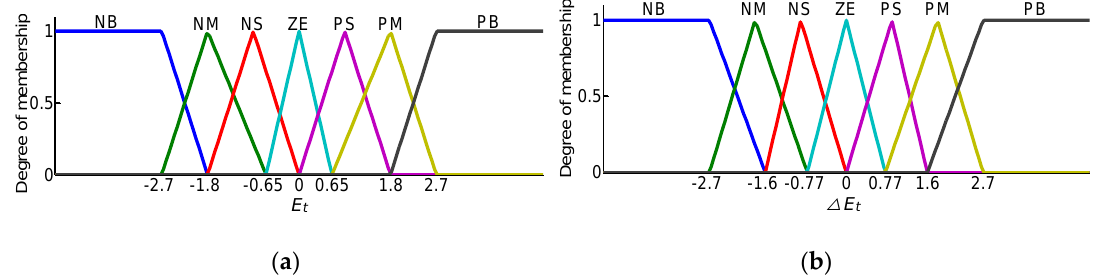
Figure 7. Membership function curve for ( a ) steering angle error and ( b ) its rate.